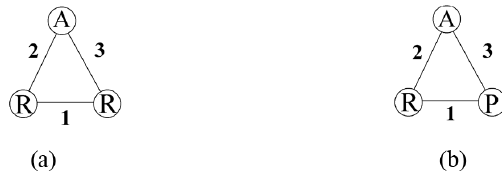
Figure 20. Specialized chains of the time-reporting